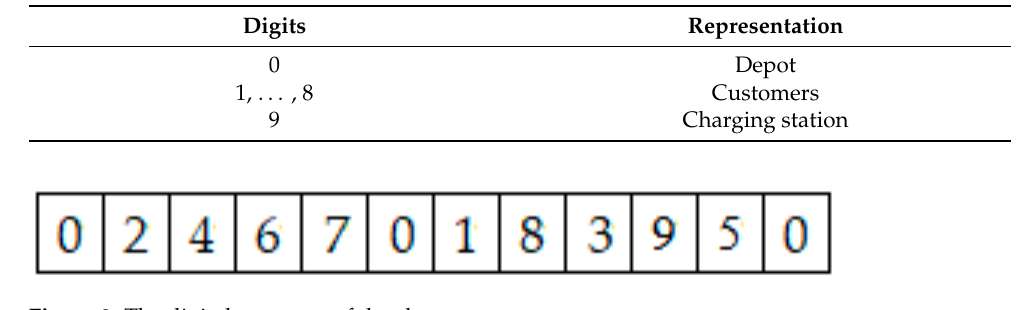
Figure 2. The digital sequence of the chromosome.